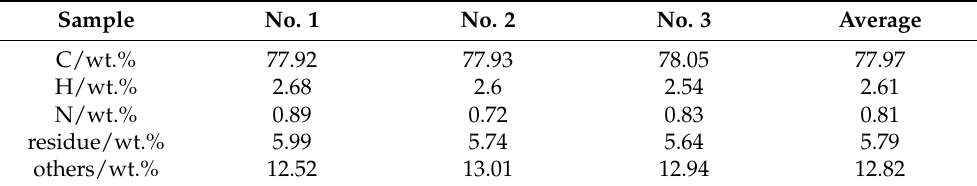
Table 1. Percentage of elements in pine tree biochar produced by flame-curtain pyrolysis estimated from CHN measurement.